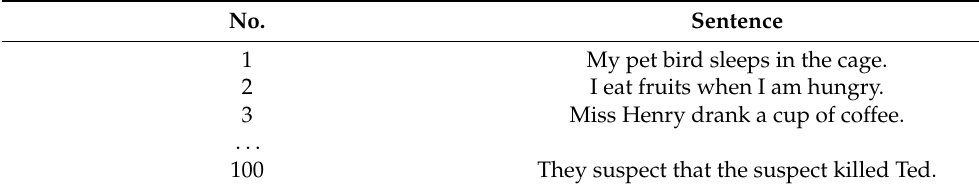
Table 3. Samples of the scripts.